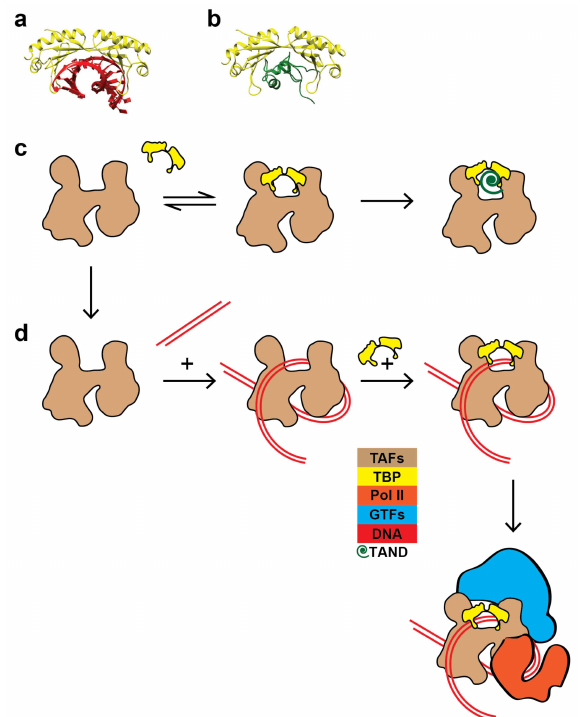
Figure 5. Schematic of TAFs–DNA assembly pathways in vitro. ( a ) X-ray crystal structure of TBP in complex with TATA-box DNA (PDB:1YTB). ( b ) NMR structure of TBP in complex with the N-terminal domain of TAF1 (TAND) (PDB:1TBA). ( c ) Dynamic association of TBP with its TAFs. When TBP